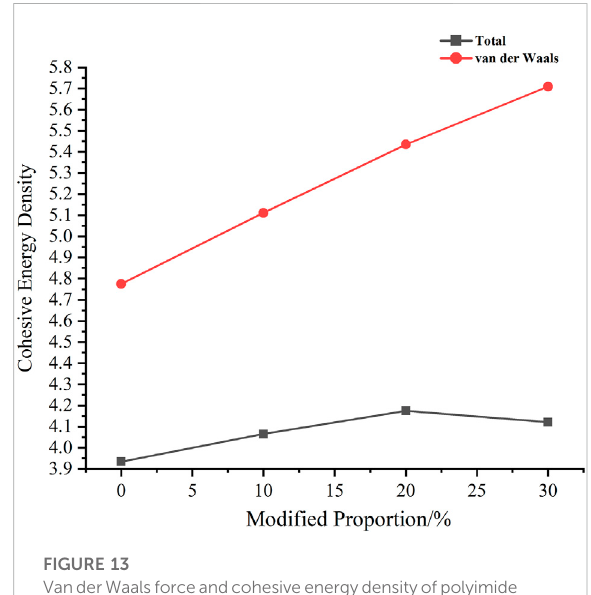
FIGURE 13 VanderWaalsforceandcohesiveenergydensityofpolyimide in different